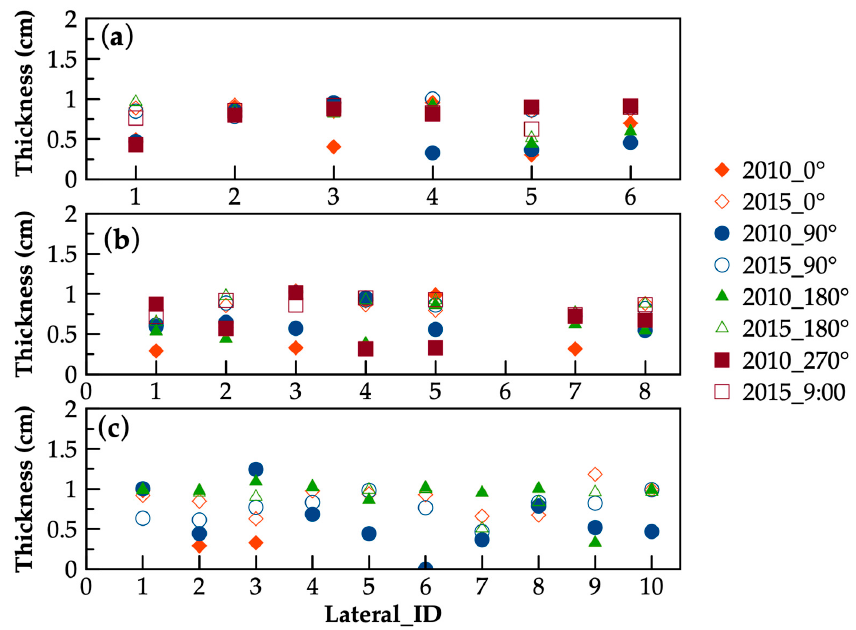
Figure 3. Lateral structural integrity in ( a ) Collector 3, ( b ) Collector 4, and ( c ) Collector 5 during